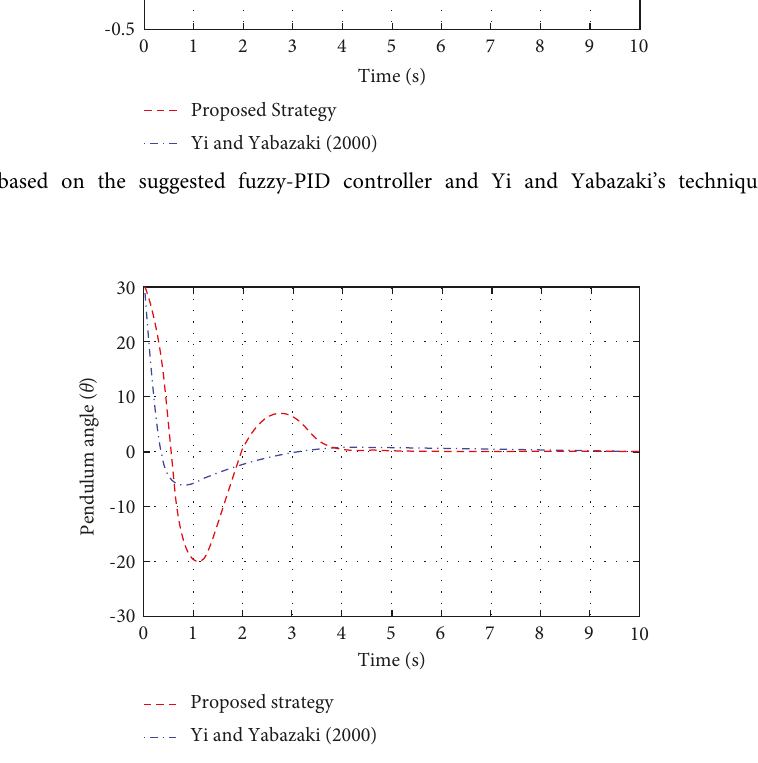
Figure 11: Pole angle based on the suggested fuzzy-PID controller and Yi and Yabazaki’s technique with [ 0 , 0 , 0 , 0 , π /6 , 0 ] initial